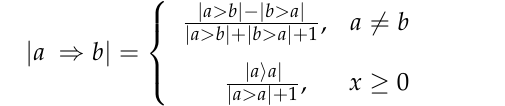
Figure 12. Distribution of loading time. The calculated means and standard deviations for all four activity durations are shown in Table 3. The return route for the trucks was longer than the hauling route which is reflected in the data. These values were assumed to be the initial input parameters for the base DES model. Table 3. The mean and standard deviation of each activity. Activity